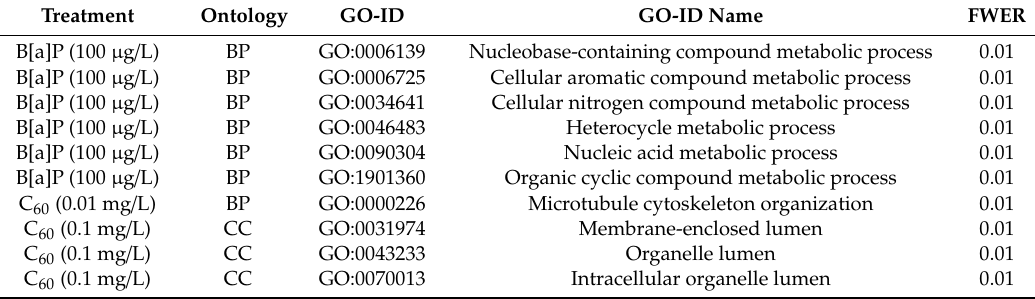
Table 3. Subset of enriched Gene Ontology (GO) terms with an family wise error (FWER) threshold of 1% (or 0.01) following B[a]P (5–100 µ g / L ), C 60 (0.01–1 mg / L) and a mixture of B[a]P (5–100 µ g /